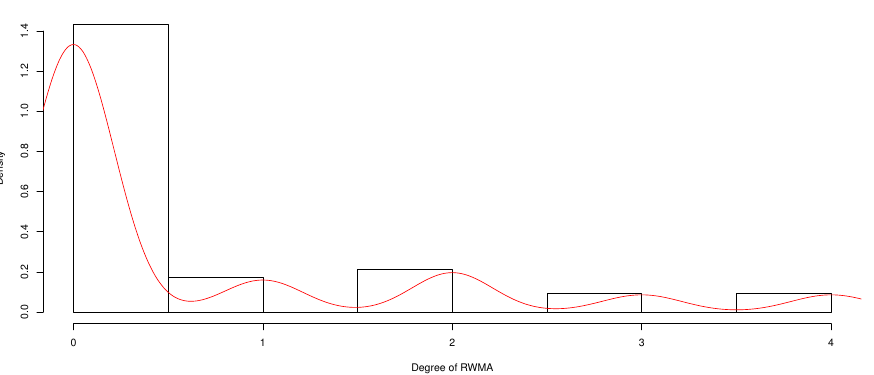
Figure 1. Frequencies of the degree of RWMA (from none to